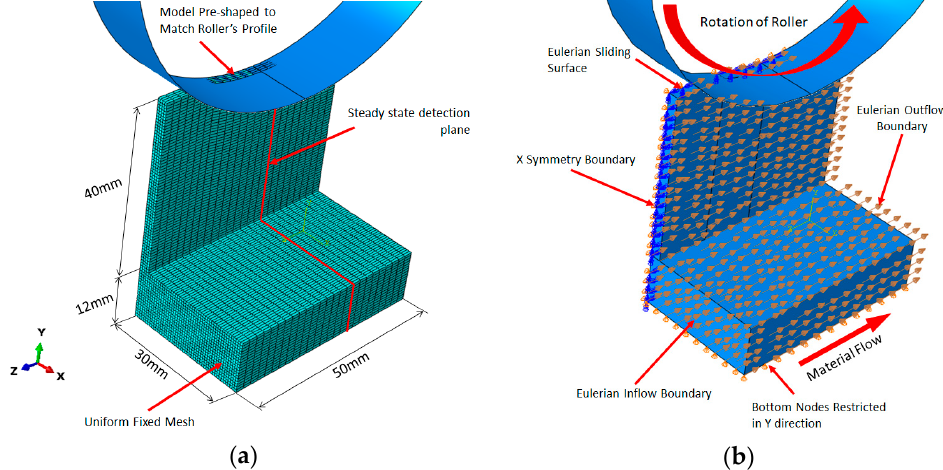
Figure 3. Short Eulerian steady-state model: ( a ) dimensions and mesh; ( b ) material flow and boundary conditions. The interface between the roller and the wall was specified as the Eulerian sliding surface. On the bottom surface, the nodal displacement was constrained in the vertical direction to represent the clamping, while on the inflow and outflow borders, all the nodal displacements were fixed. The rolling load of 50 kN was imposed by prescribing a vertical displacement of the roller. Translation of the roller was constrained in all directions, while rotation was allowed only around the X axis. An angular velocity boundary condition was applied to the roller around of the spinning axis in order to provide the rolling torque.